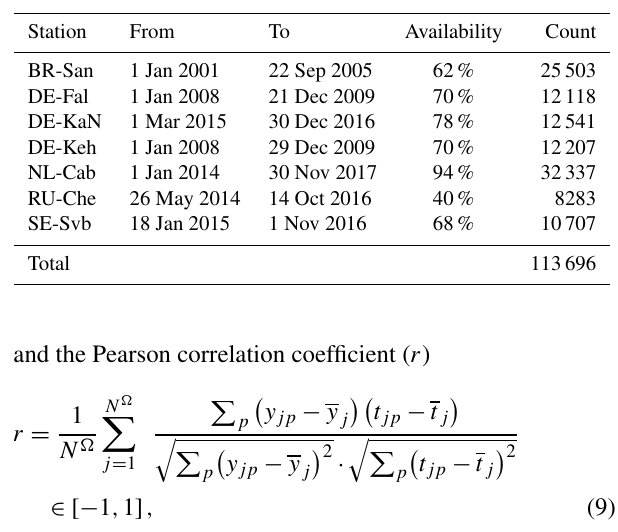
Table 2. Time series information for the meteorological towers se- lected for training and validation. Count and availability are mea- sured at hourly intervals and not at the original resolution of each time